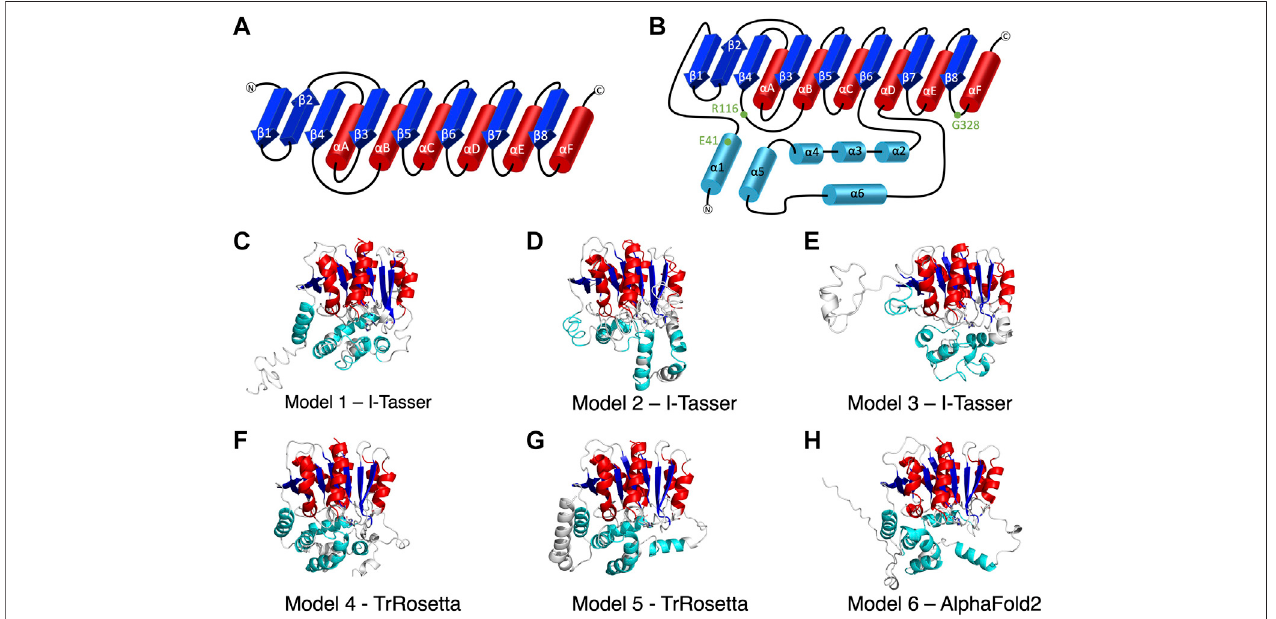
FIGURE1| The secondary structure ofalpha/betahydrolase domain-containing5(ABHD5). (A) Thesecondarystructure diagramofthe “ canonical ” α / β hydrolase fold characterized by six α helices (red) and eight β strands (blue). The catalytic triad in the α / β hydrolase fold family is made up of 1) a nucleophilic residue (Ser, Cys, or Asp) after β 5, 2) an acidic residue after β 7, and 3) a conserved His after β 8. (B) The secondary structure diagram of ABHD5 with two insertion regions (cyan). The fi rst insertionregionisan α helix( α 1),locatedbefore β 1,andthesecondinsertionregioniscomposedof fi ve α helices( α 2 – α 6)between β 6and α D. (C – H) Thesixmodels ofABHD5builtfromdifferenthomologymodelingtools.Models1,2,and3arefromI-TASSER;Models4and5arefromTrRosetta;andModel6isfromAlphaFold2.The “ canonical ” six α helices and eight β strands forall models areshown in red and blue cartoon representations,respectively. The six insertion α helices are shown in cyan. The secondary structures are de fi ned as: insertion α 1 (residues 33 – 46), β 1 (residues 53 – 59), β 2 (residues 64 – 71), β 3 (residues 80 – 84), α A (residues 89 – 103), β 4 (residues 106 – 111), α B (residues 126 – 143), β 5 (residues 149 – 154), α C (residues 157 – 171), β 6 (residues 172 – 181), insertion α 2 (residues 198 – 207), insertion α 3 (residues 221 – 229), insertion α 4 (residues 232 – 240), insertion α 5 (residues 245 – 257), insertion α 6 (residues 259 – 270), α D (residues 278 – 288), β 7 (residues 292 – 298), α E (residues 305 – 314), β 8 (residues 319 – 325), and α F (residues 331 – 351). Asn155, Asp303, and H329 are drawn in sticks with the carbon atoms in white, nitrogen atoms in blue, and oxygen atoms in red. The hydrogen atoms are not